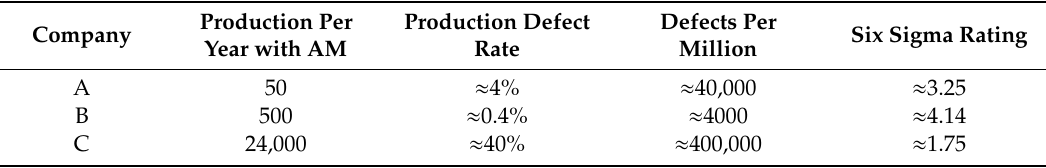
Table 7. Comparison of Sigma process performance based on their internal production defect rate solely of additive manufactured